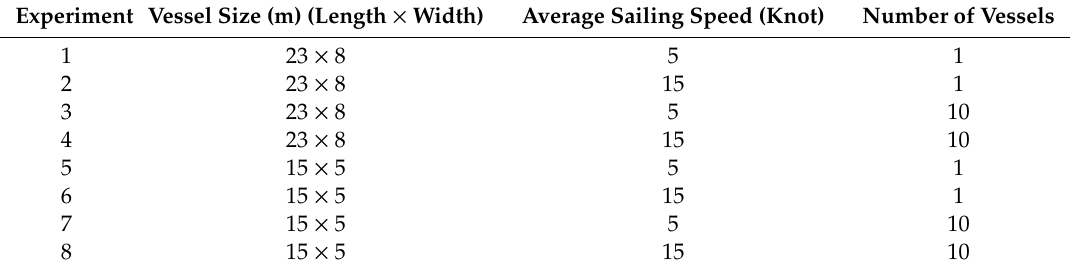
Table 1. Numerical experiments to quantify wake e ff ects on marshes. In experiments with the number of vessels greater than one, a vessel enters the domain every 5